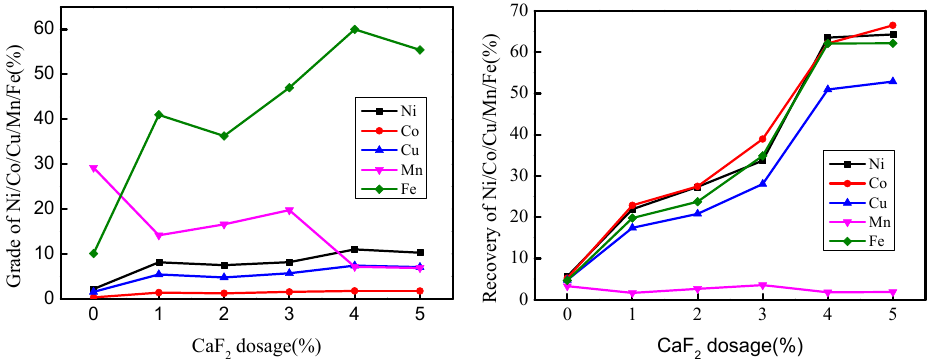
Figure 3. E ff ect of CaF 2 addition on the concentration of valuable metals. Figure 3. Effect of CaF 2 addition on the concentration of valuable metals.